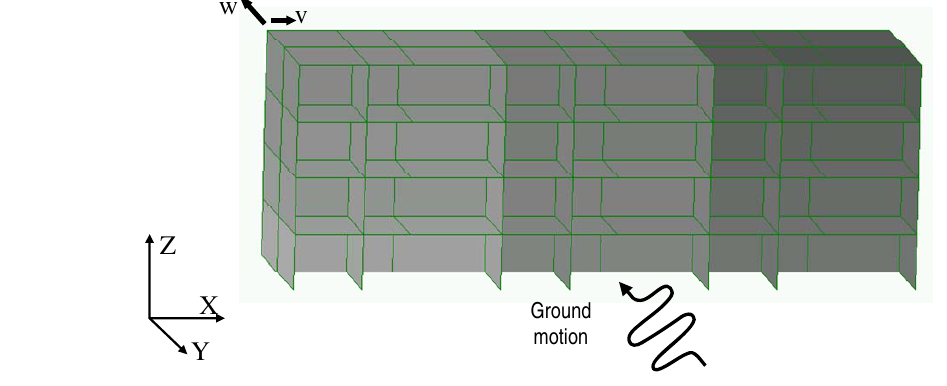
Fig 9 . Computational model of the building